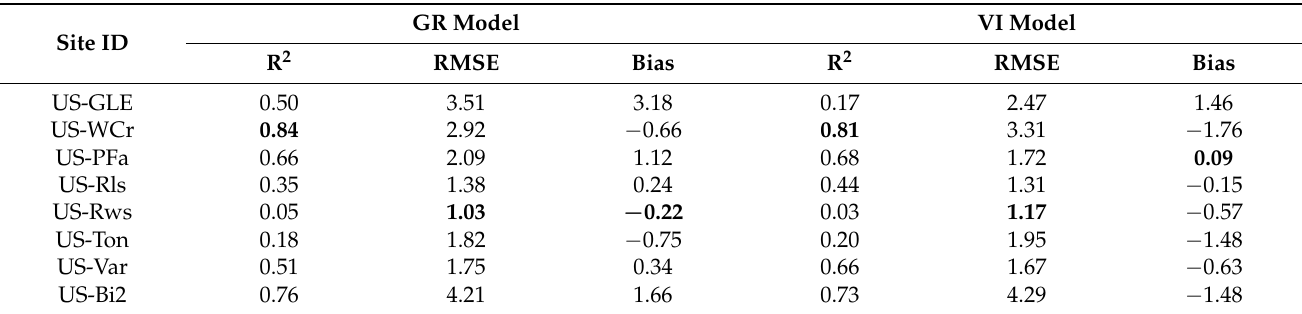
Table 6. Coefficient of determination (R 2 ), root mean square error (RMSE, gC/m 2 /d) and bias (gC/m 2 /d) for GPP GR , GPP VI , and GPP EC